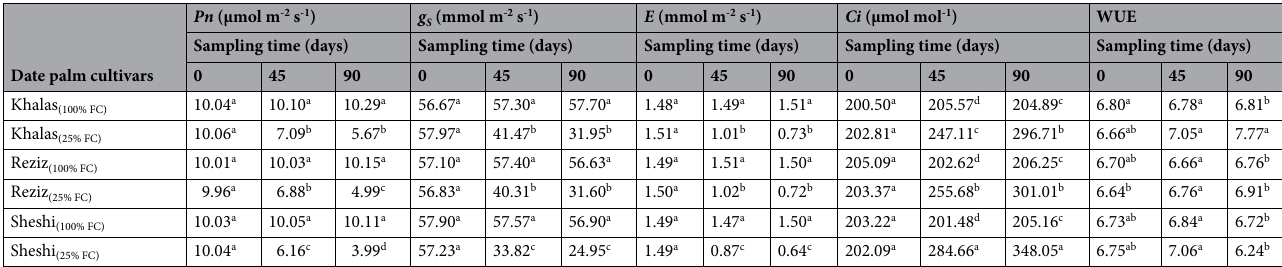
Table 1. Photosynthesis ( Pn ), stomatal conductance ( gs ), transpiration ( E ), intercellular CO 2 concentration ( Ci ), and water use efficient (WUE) of date palm cvs. Khalas, Reziz, and Sheshi at 100 and 25% field capacity. Different letters within each column indicate significant mean difference at p ≤ 0.05. The statistical analysis was based on a completely randomized design (CRD). Each data are the mean of three independent replicates. Duncan’s Multiple Range Test (DMRT) was applied to determine the least significance difference (LSD) between treatment